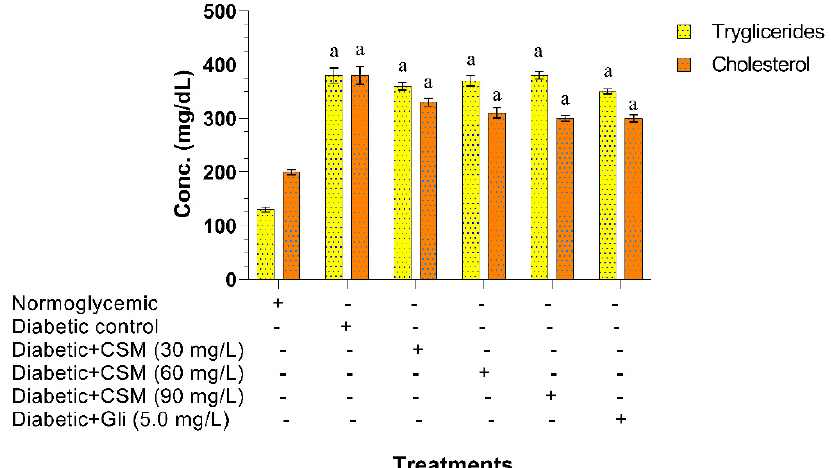
Figure 7. Effect of CSM on glucose-induced zebrafish triglycerides and cholesterol levels at the end of the experimental period (14 days). Data are expressed as the mean ± SE. a p ≤ 0.05. when compared to normoglycemic control group. The letters indicate significant differences between the different treatments. CSM; methanol extract from the seed of S. purpurea , Gli; glibenclamide.